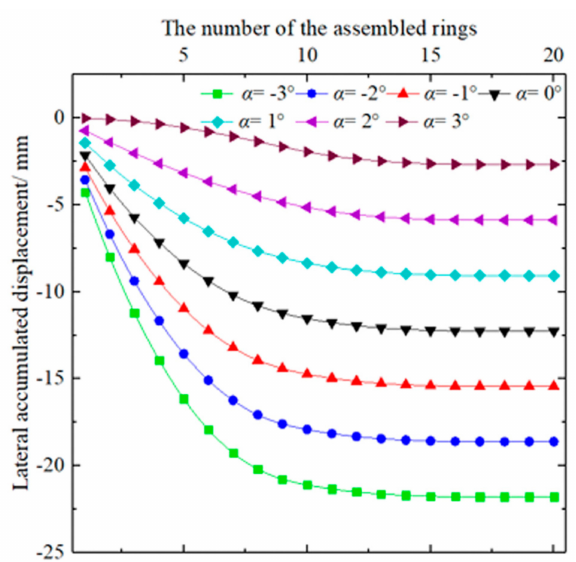
Figure 11. Lateral accumulated displacement curves of the first 20 assembled rings under di ff erent thrust deviation